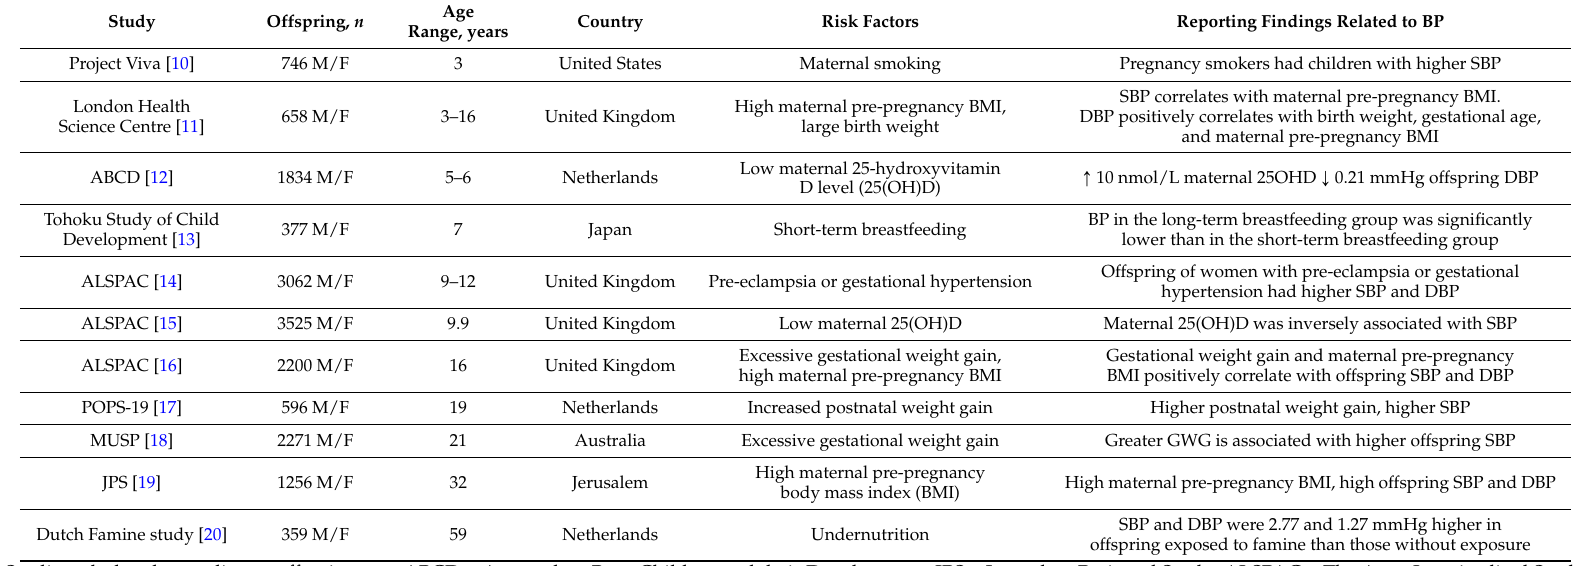
Table 1. Effects of developmental risk on offspring blood pressures in human cohort